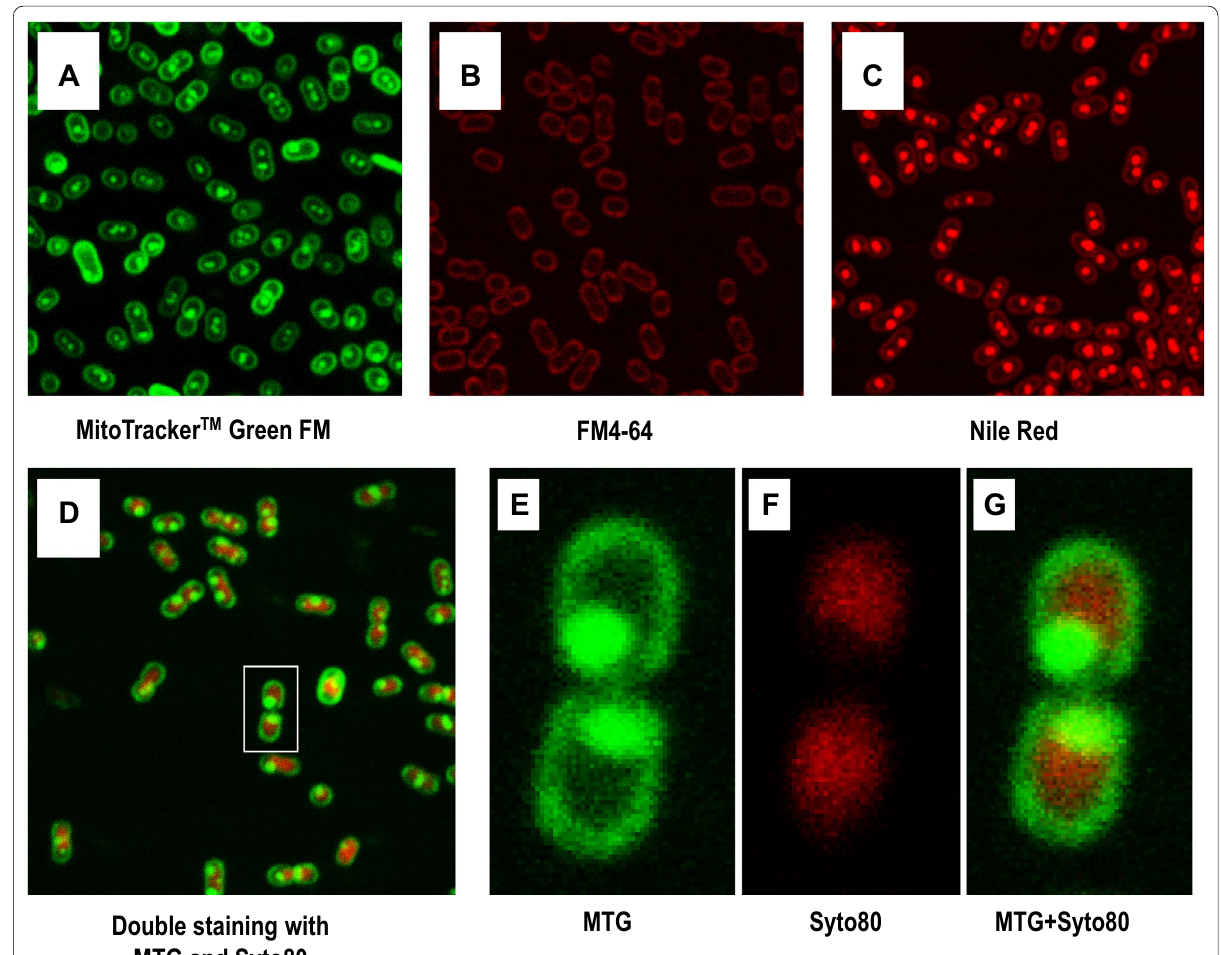
Fig. 1 Staining of P. denitrificans cells with different fluorescent dyes. In all cases, cells were grown to an OD 660 of about 0.75–1 and stained with: A MitoTracker ™ Green FM (MTG) (1 µM); B FM4‑64 (1 µM); C Nile Red (1 µM); D Double staining with MTG (1 µM) and Syto80 (500 nM). E – G Details of daughter cells from a recently divided mother cell. MTG image ( E ), Syto80 image ( F ), overlay ( G ). Cells were imaged using two different lasers (a blue‑argon Laser, 488 nm, for excitation of MTG and a green‑helium/neon laser, 543 nm, for excitation of